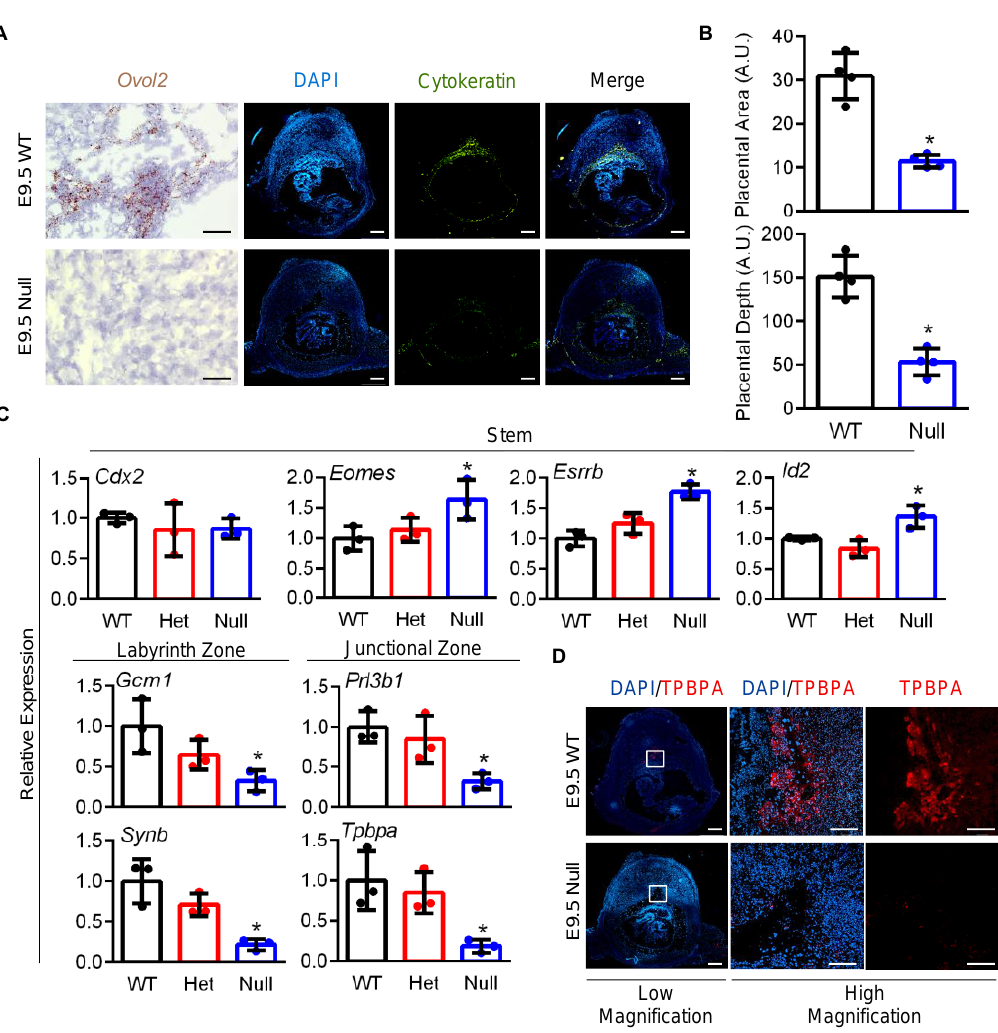
Figure 2. Placental development is impaired in Ovol2 -deficient embryos. ( A ) Evaluation of Ovol2 expression in wild-type (WT) and Ovol2- null placentas on E9.5. Immunohistochemical staining of cytokeratin was used to denote the location of placentas. Note poor placental development in Ovol2- null placentas. ( B ) Quantitative analysis of placental area and depth comparing WT and Ovol2- null placentas. ( C ) Transcript analysis of stem ( Cdx2, Eomes, Esrrb , and Id2 ) and differentiation markers ( Gcm1 , Synb , Prl3b1 , and Tpbpa ) comparing WT, heterozygote (Het), and Ovol2 -null placentas at E9.5. ( D ) Immunohistochemical staining of differentiation marker TPBPA in WT and Ovol2 -null placentas. Values significantly different from WT (N = 3 – 4 from different dams, P < 0.05) are denoted with an asterisk (*). Scale bars = 500 µm (low magnification) and 100 µm (high magnification). Graphs represent means (SD).